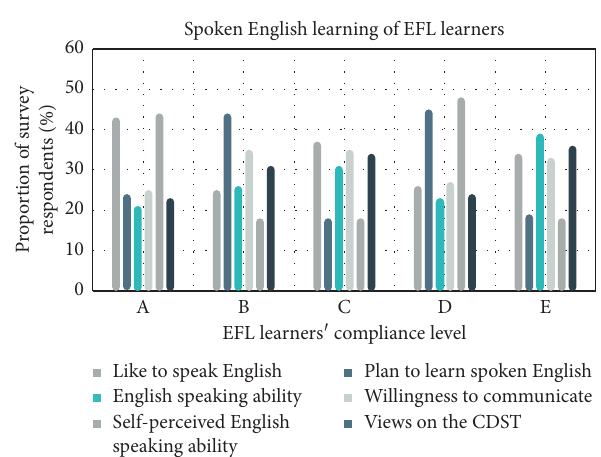
Figure 2: Spoken English learning of EFL